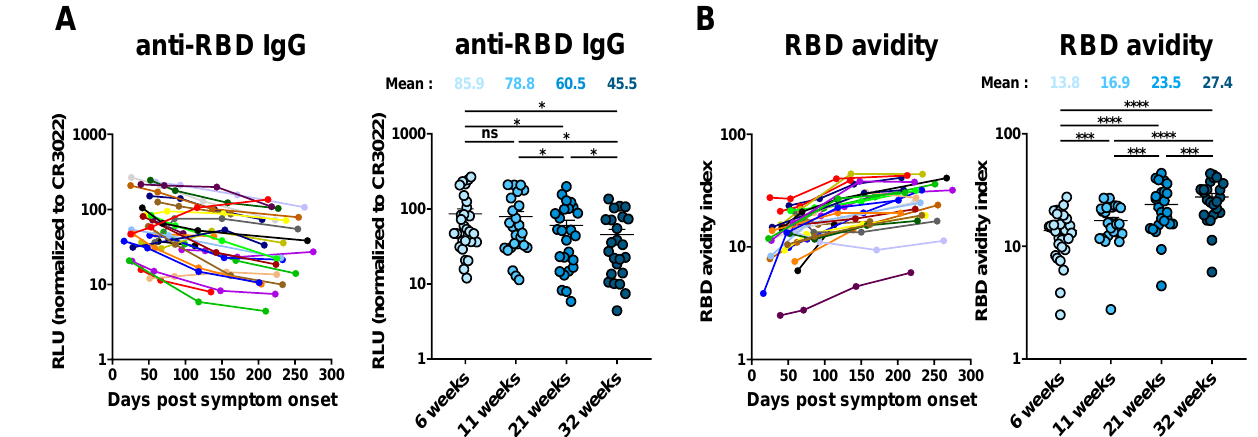
Figure 2. RBD avidity of specific IgG increases over time in SARS-CoV-2 convalescent individu- als. ( A ) Level of RBD-specific IgG was measured using an indirect ELISA. Anti-RBD Ab binding was detected using HRP-conjugated anti-human IgG. Relative light unit (RLU) values obtained were normalized to the signal obtained with the anti-RBD CR3022 mAb present in each plate. ( B ) An indirect ELISA was performed to calculate the RBD avidity index. ( A , B ) In the left panels, each curve (shown in a different color) represents the values obtained with the plasma of one donor at every time point tested in triplicate, and in the right panels, plasma samples were grouped in different time points (6, 11, 21, and 32 weeks PSO). ( A , B ) significance was tested using a repeated measures one-way ANOVA with a Holm – Sidak post-test. Error bars indicate means ± SEM. (* p < 0.05; *** p < 0.001; **** p < 0.0001; ns, Statistical non-significant).